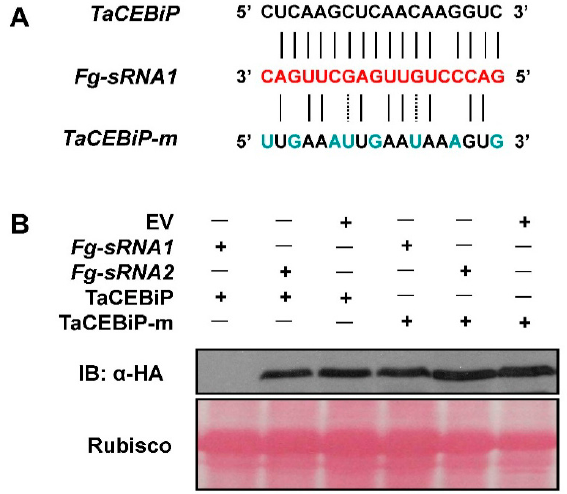
Figure 6. Fg-sRNA1 affects accumulation of TaCEBiP in vivo. ( A ) Target site and target site synonymously mutated versions of TaCEBiP were used in this study; and ( B ) in N. benthamiana , co-expression of Fg-sRNA1 with its targets (HA-tagged), TaCEBiP or TaCEBiP-m, revealed target silencing by means of Western blot analysis. Co-expression of Fg-sRNA1 with different versions of targets were used as controls.